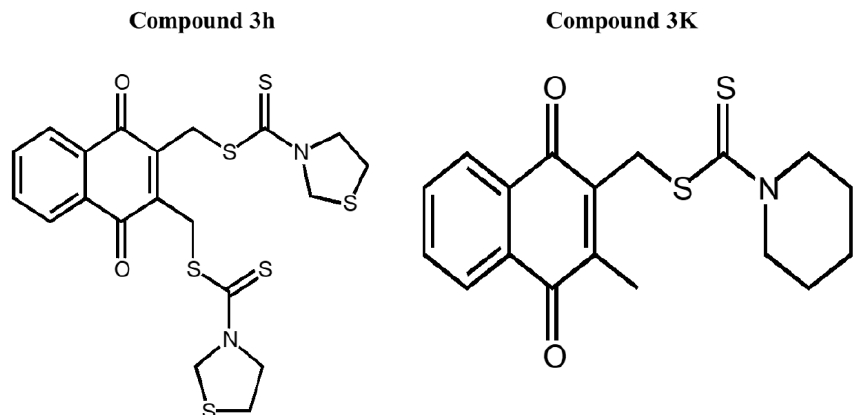
Figure 2. Chemical structures of compounds 3h and 3K .